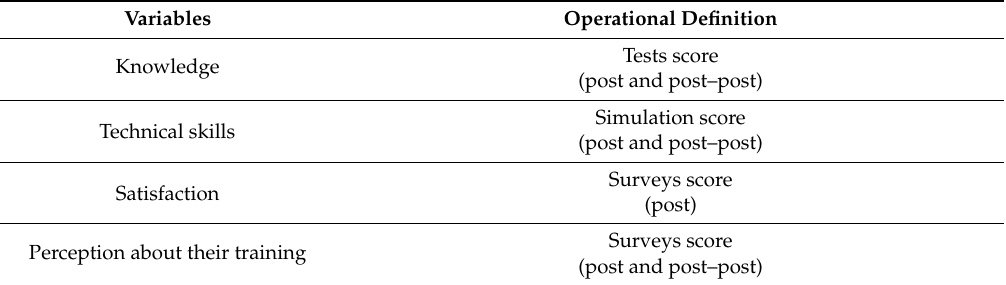
Table 1. Operational definition of the dependent